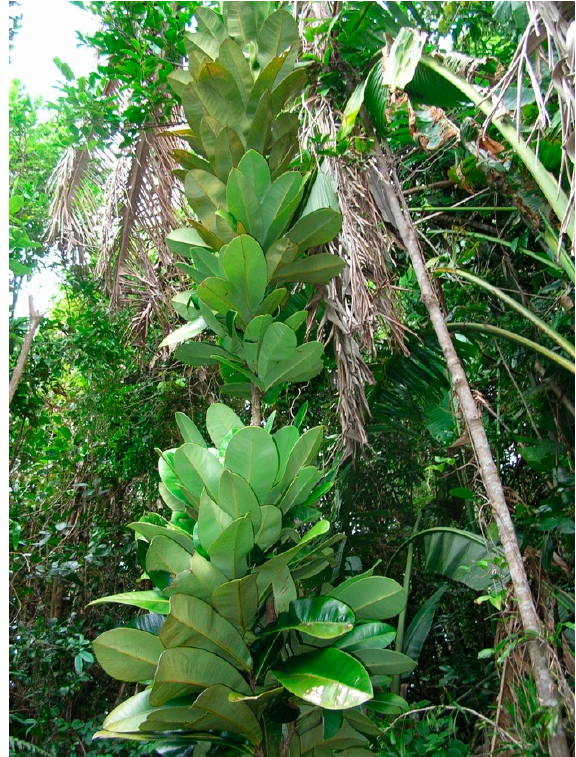
Figure 1. Vepris macrophylla tree.